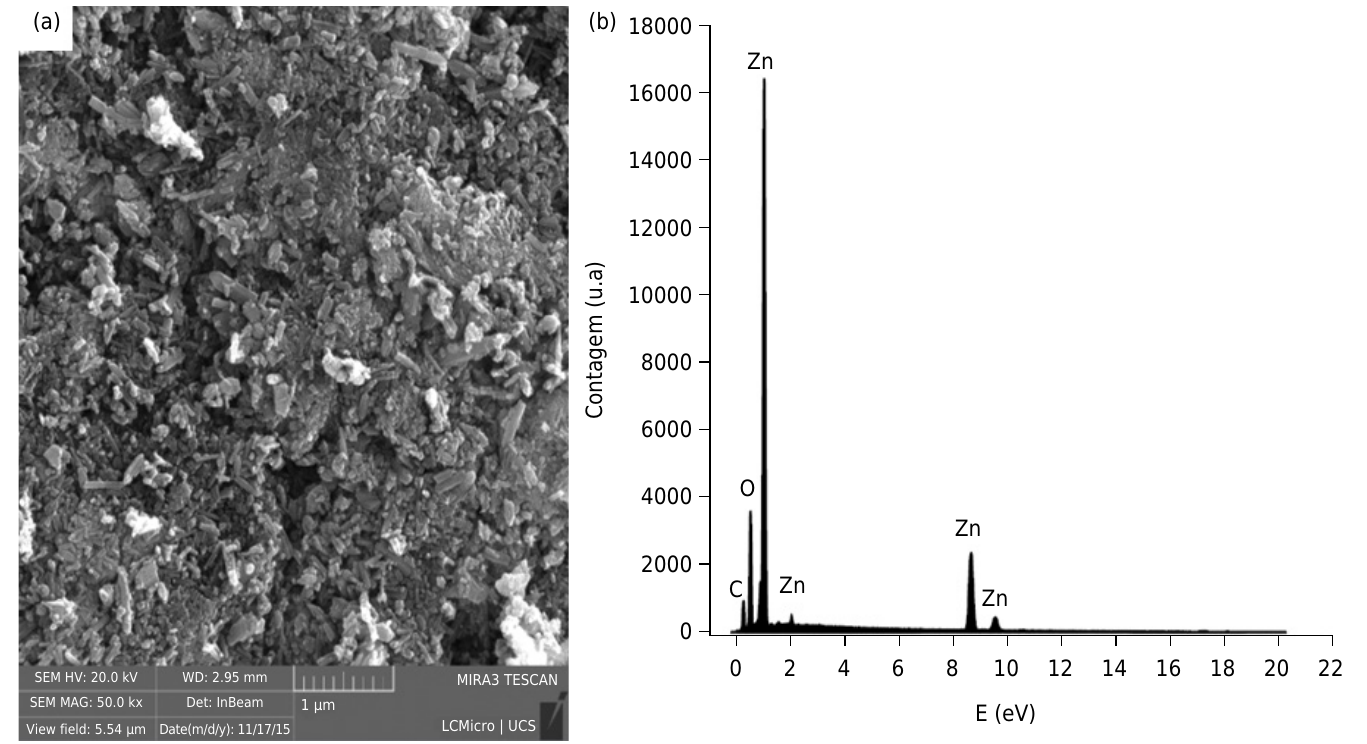
Figure 1. Micrographs obtained by Field Emission Gun-Scanning Electron Microscopy (FEG-SEM) of NPs-ZnO (a) and Energy Dispersive